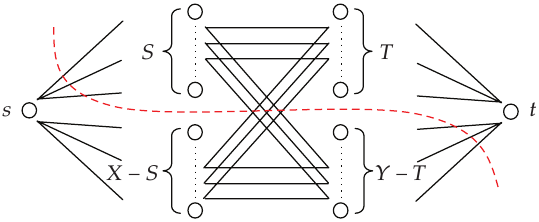
Figure 2: For proof of Lemma 2.1, red dashed line is the minimum